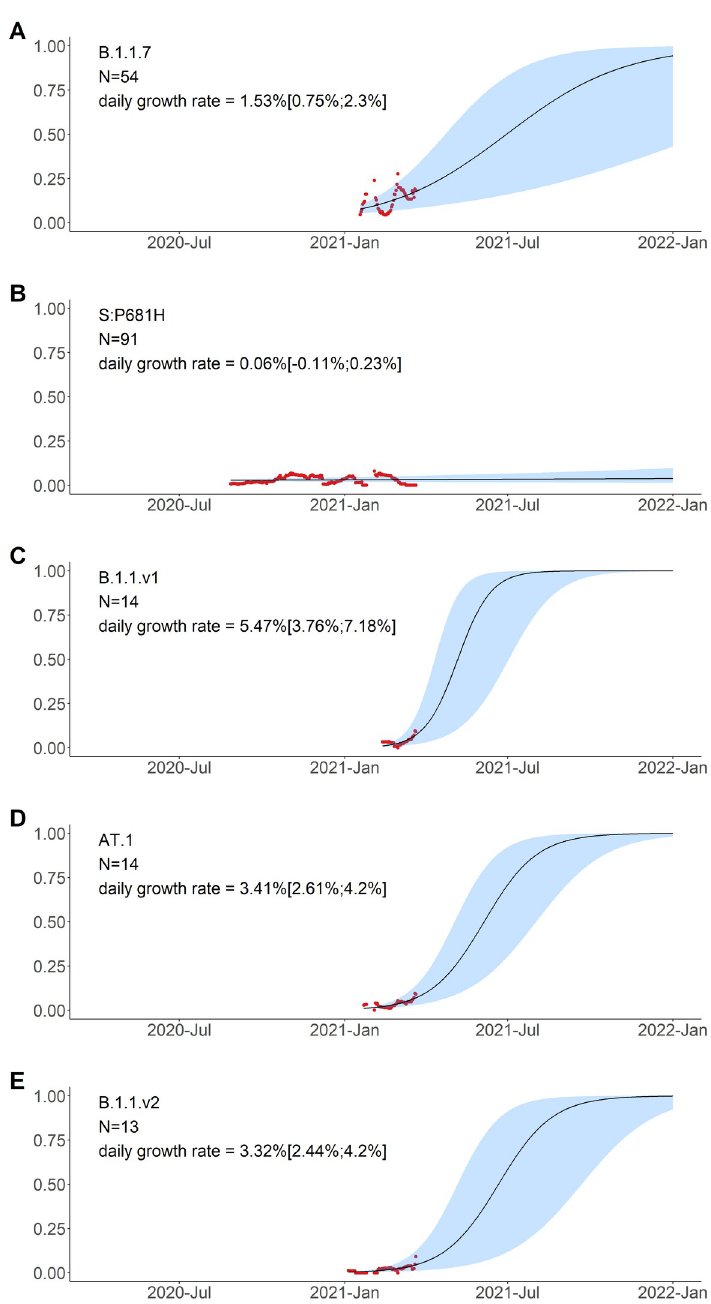
Fig 8. Logistic growth model for the five remaining amino acid variants with high frequencies in Russia in February-March. Notations are the same as in Fig 6. S:P681H has been observed both independently and as part of B.1.1.7; in panel B, the cases of B.1.1.7 are not shown, by excluding the S:P681H+nsp3:I1412T combination. [20]) and episodic (according to the MEME model [21]) positive selection both in the global [29] and in the Russian dataset (p = 0.0396 for the MEME model and p = 0.0268 for the FEL model, the likelihood-ratio test), as well as a rapid increase in frequency of non-reference vari- ants in the global dataset [29]. While the global frequency of 211V has remained low ( < 0.4%),